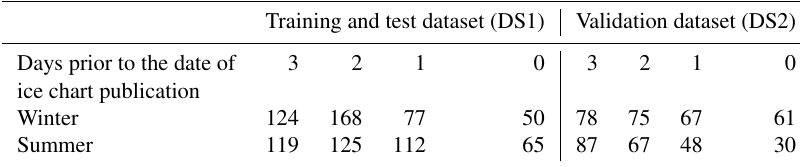
Table 2. Distribution of the image acquisition dates prior to the publication of the reference ice chart. Training and test dataset